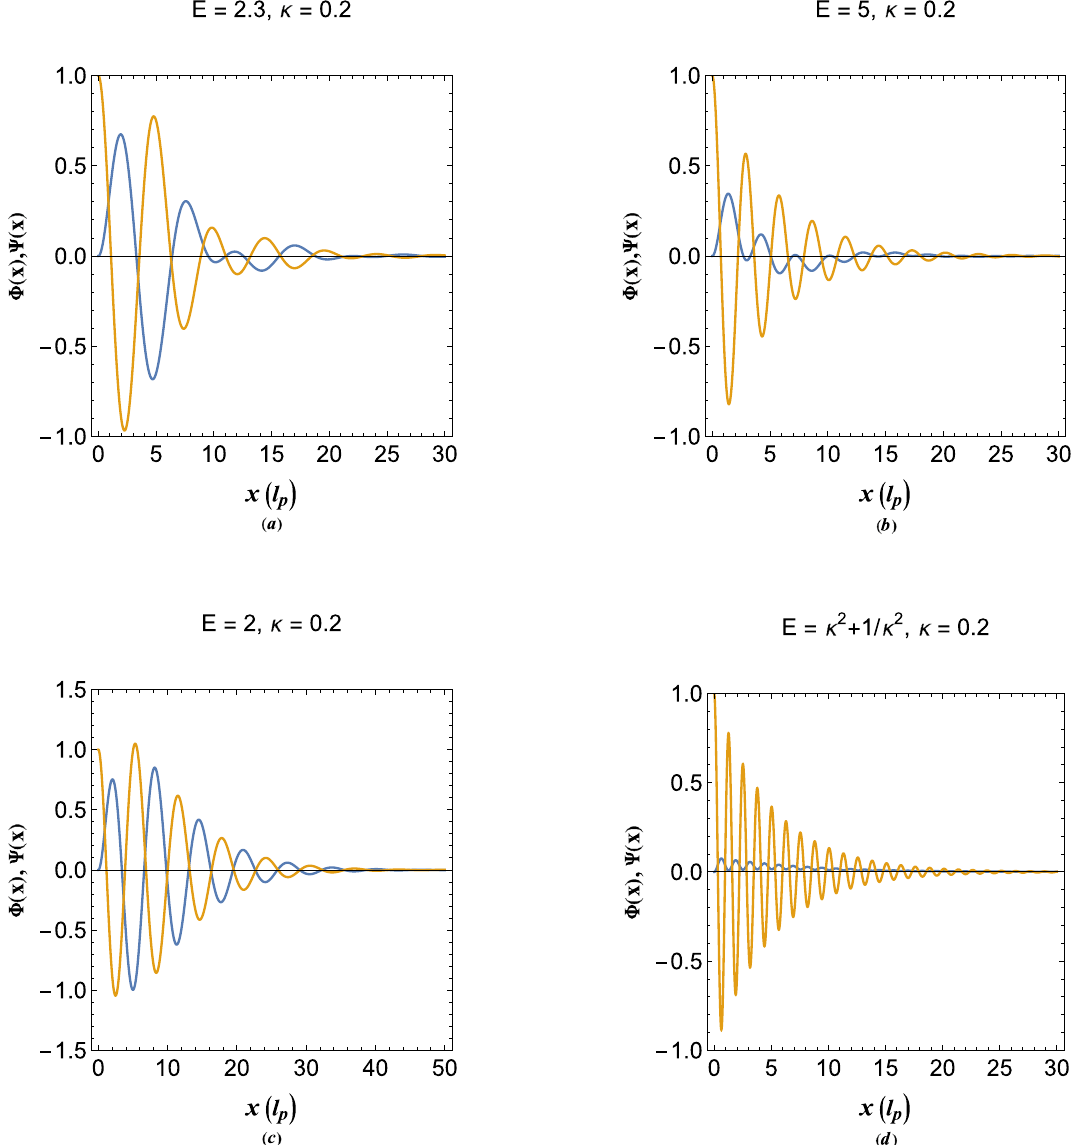
Figure 7. ( a ) The collective oscillation profiles of the local electron density and electrostatic energy of damped plasmons at energy orbital between the two exceptionl points. ( b ) The collective oscillation profiles of the local electron density and electrostatic energy of damped plasmons at energy orbital above the two exceptional points. ( c ) The collective oscillation profiles of the local electron density and electrostatic energy of damped plasmons at exceptional-point energy orbital (orbital at the main exceptional point E = 2 ). ( d ) The collective oscillation profiles of the local electron density and electrostatic energy of damped plasmons at second exceptional point 2 + 1 /κ 2 energy orbital (orbital at the second exceptional point with the energy, E = κ